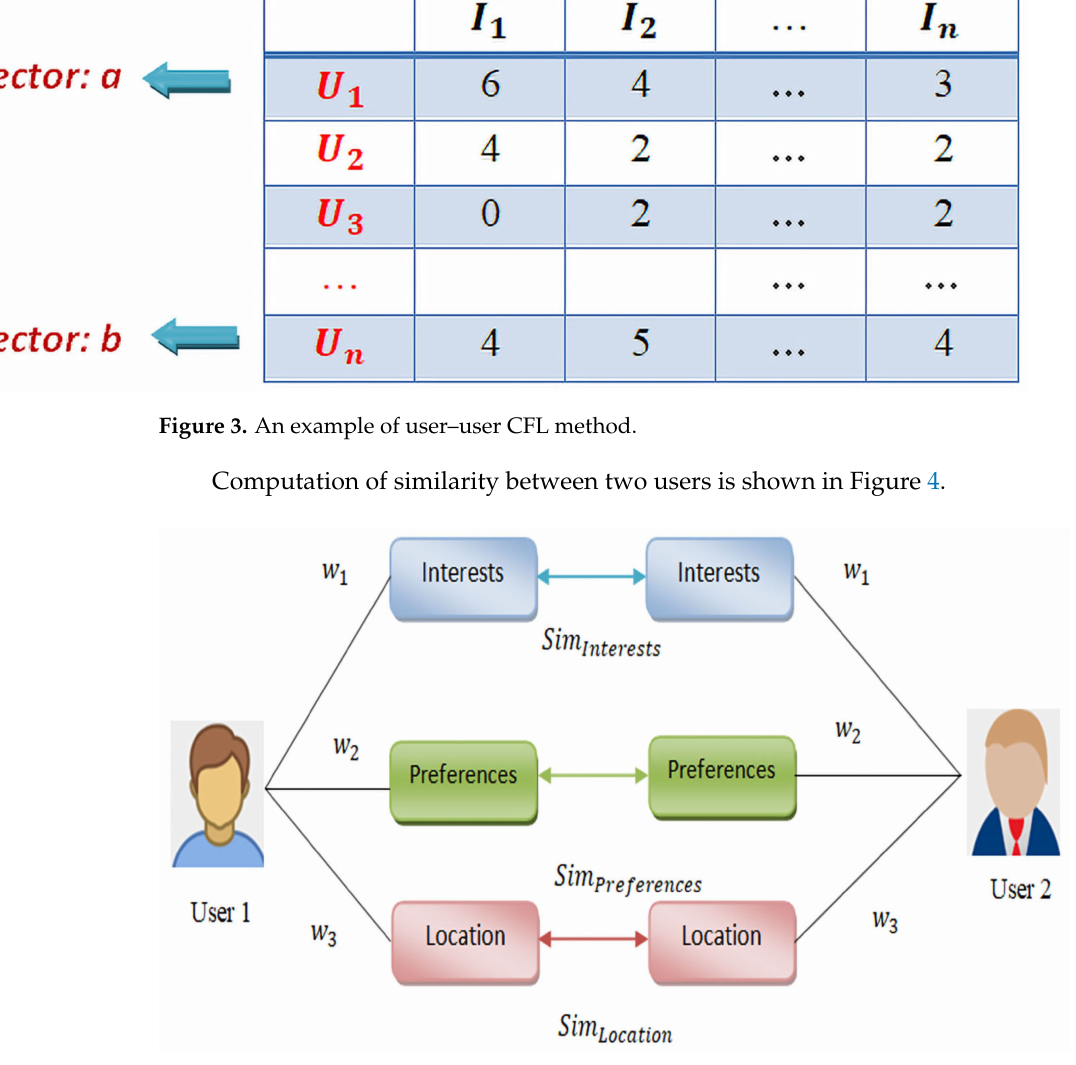
Figure 4. Computation of similarity between two